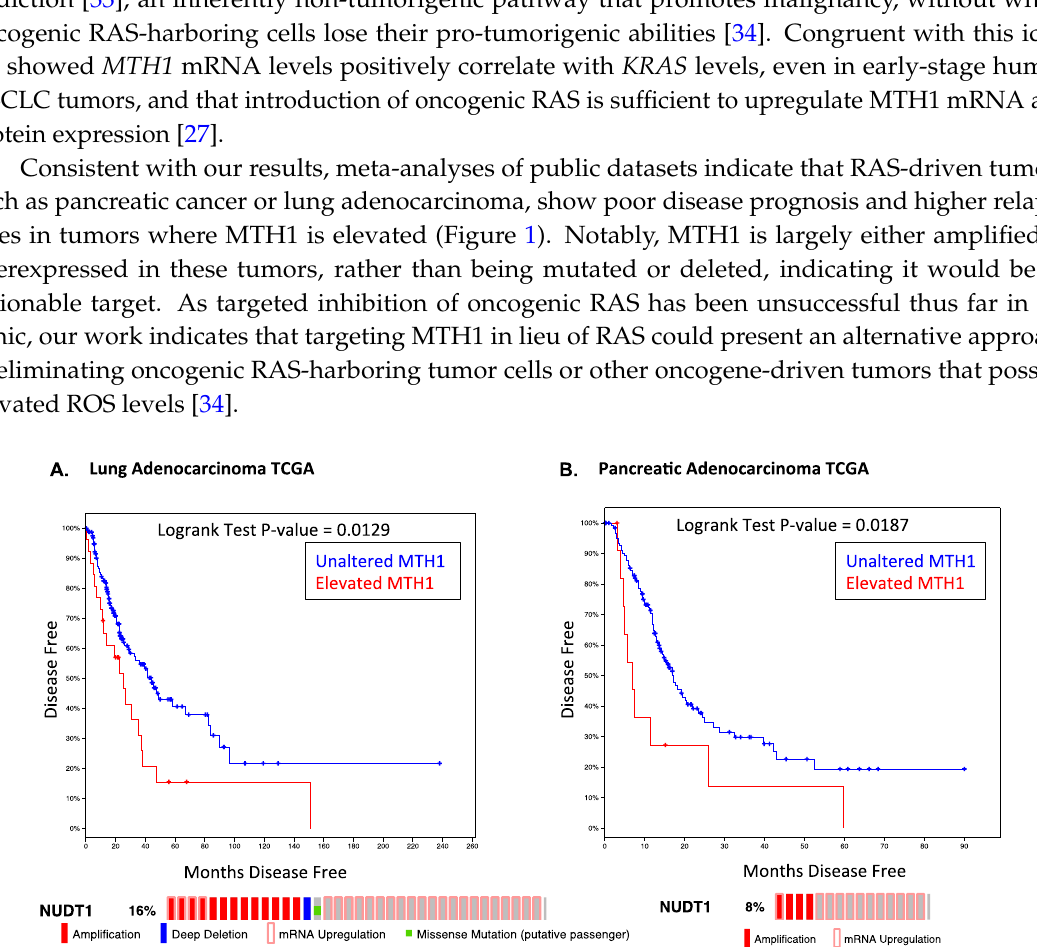
Figure 1. Effect of elevated MTH1 mRNA levels on disease-free survival in RAS-driven cancers. Data and statistics were obtained from the cBioportal website for the indicated TCGA provisional datasets. The percentage of the total samples in which MTH1 ( NUDT1 ) gene is amplified or mRNA is upregulated is shown below the survival curves. ( A ) Lung adenocarcinoma dataset. Kaplan-Meier curve data represent 221 cases. Median months disease-free ( NUDT1 unaltered) = 44.02, median months disease-free ( NUDT1 elevated) = 25.33. ( B ) Pancreatic adenocarcinoma dataset. Kaplan-Meier curve data represent 141 cases. Median months disease-free ( NUDT1 unaltered) = 17.12, median months disease-free ( NUDT1 elevated) = 6.93.